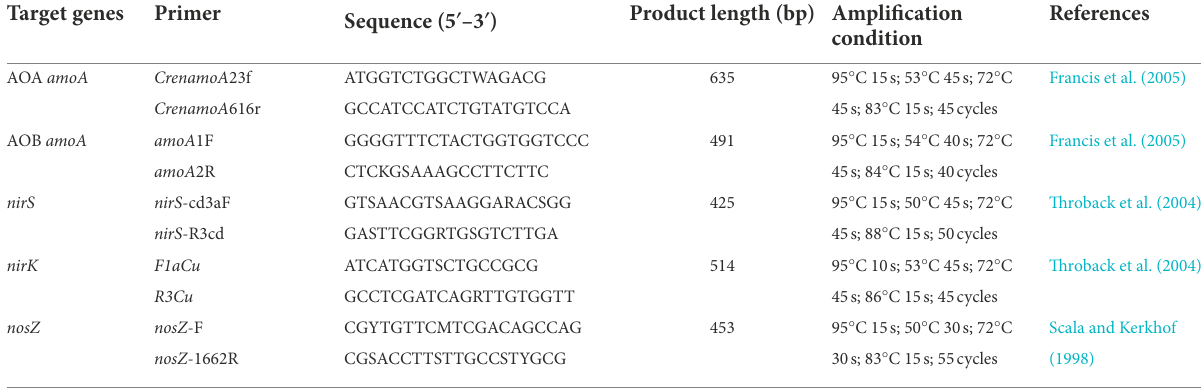
TABLE 2 Primers for nitrifier (AOA and AOB amoA ) and denitrifier ( nirK , nirS and nosZ ) genes and their thermal cycling conditions for qPCR. Target